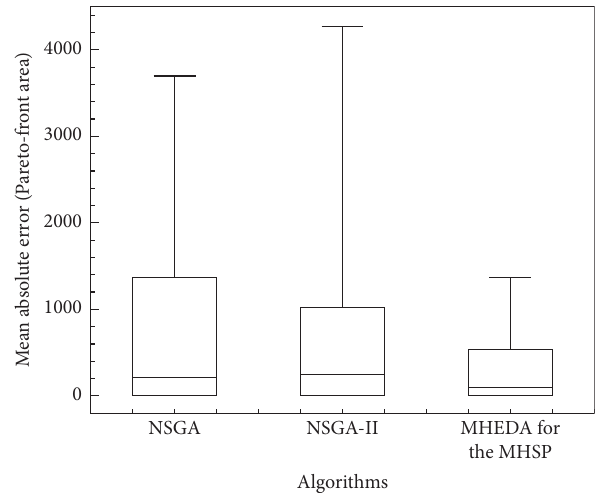
Figure 11: Comparison results for the MHSP using the mean absolute